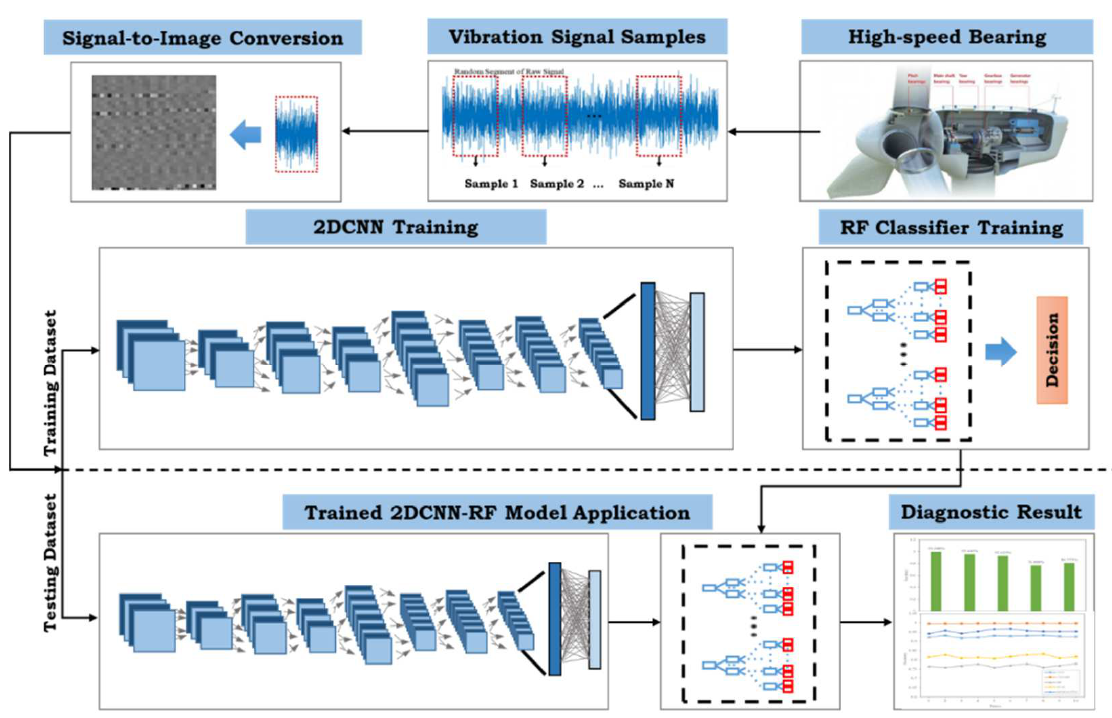
Figure 4. The flowchart of the proposed 2DCNN-RF scheme. Algorithm 1 Steps of the implementation of the improved 2DCNN-RF model: Input: Bearing-vibration-signal